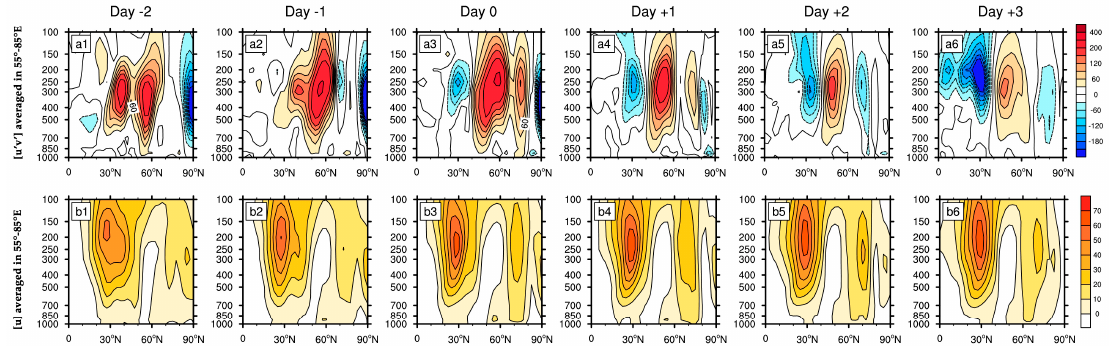
Figure 2. Pressure-latitude cross section in blocking high areas of the mean [ u'v' ] (unit: m 2 s − 2 ) and zonal wind ([ u ]) (unit: m s − 1 ). (a1–a6, b1–b6 indicate the [ u'v' ] (unit: m 2 s − 2 ) and [ u ] (unit: m s − 1 ) averaged in 55°–85°E from January 16 to 21 in 2008, respectively.)